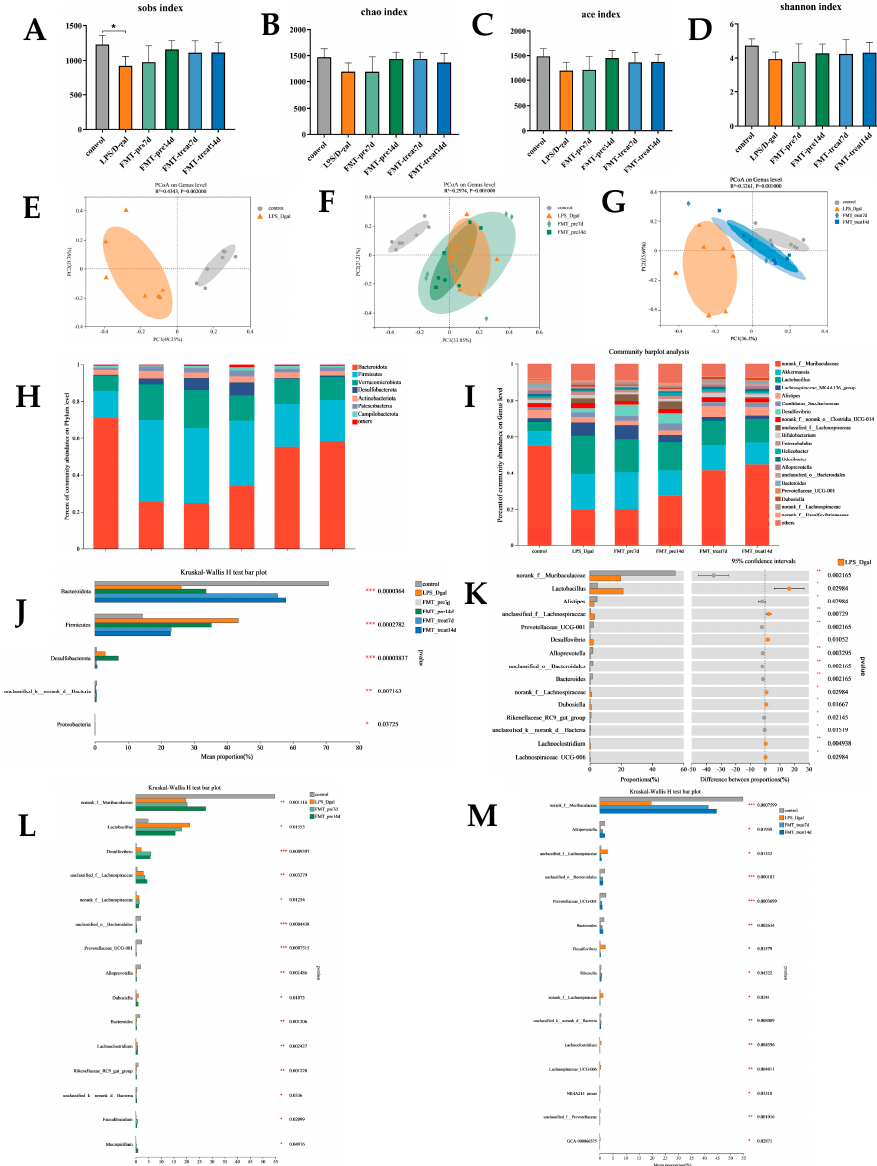
Figure 4. FMT modulated gut microbiota composition. ( A – D ) Sobs, Chao, Ace, and Shannon index of OUT level. ( E – G ) Weighted UniFrac based principal coordinates analysis (PCoA) analysis. ( H , I ) The relative abundance of bacteria on phylum and genus. ( J ) Comparative analysis of the relative abundance of bacteria at phylum level. ( K – M ) Comparative analysis of the relative abundance of bacteria on genus level. ( n = 6–7). * p < 0.05, ** p < 0.01, *** p < 0.001. Data were expressed as means ± SEM.